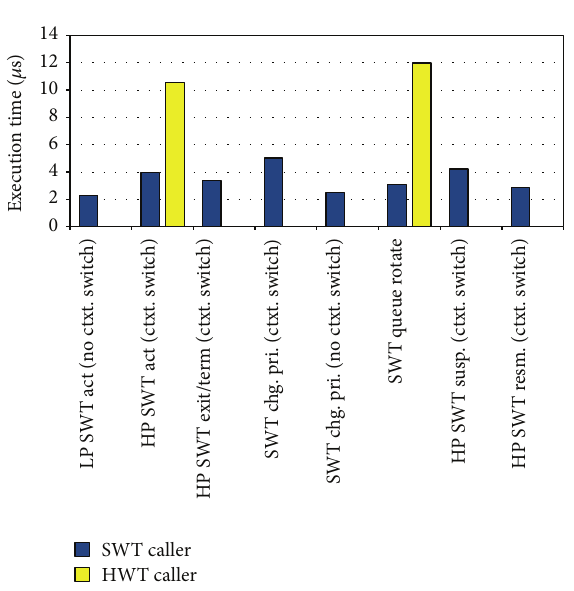
Figure 21: SWT Management API Call execution times.